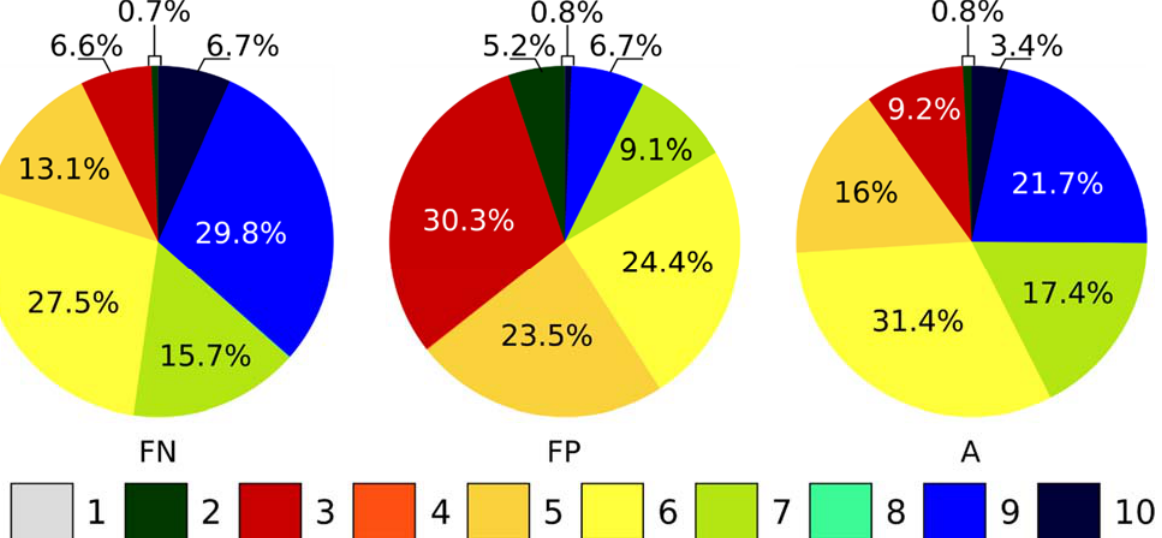
Figure 12. The distribution of terrain forms over false negatives (FN), false positives (FP) and agreement (A) of the most successful classification. 1 = flat; 2 = summit; 3 = ridge; 4 = shoulder; 5 = spur; 6 = slope; 7 = hollow; 8 = footslope; 9 = valley; 10 = depression. Terrain forms were calculated and named after Jasiewicz and Stepinski [83].